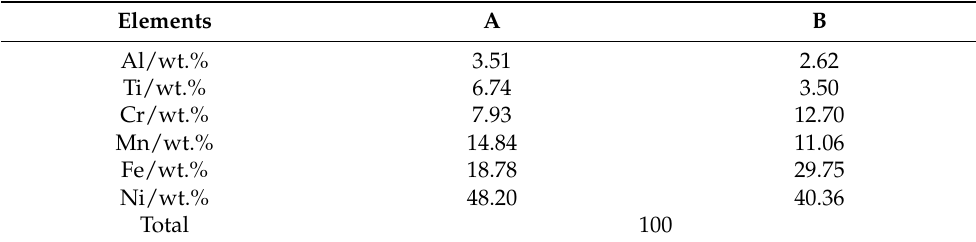
Figure 2. Microstructure morphology of (FeNi)67Cr15Mn10Al5Ti3 HEA: ( a ) 500 ×; ( b ) 5000×; A and B is the point energy spectrum of pentagram marks. Table 1. EDS results of microregion in (FeNi)67Cr15Mn10Al5Ti3 HEA.